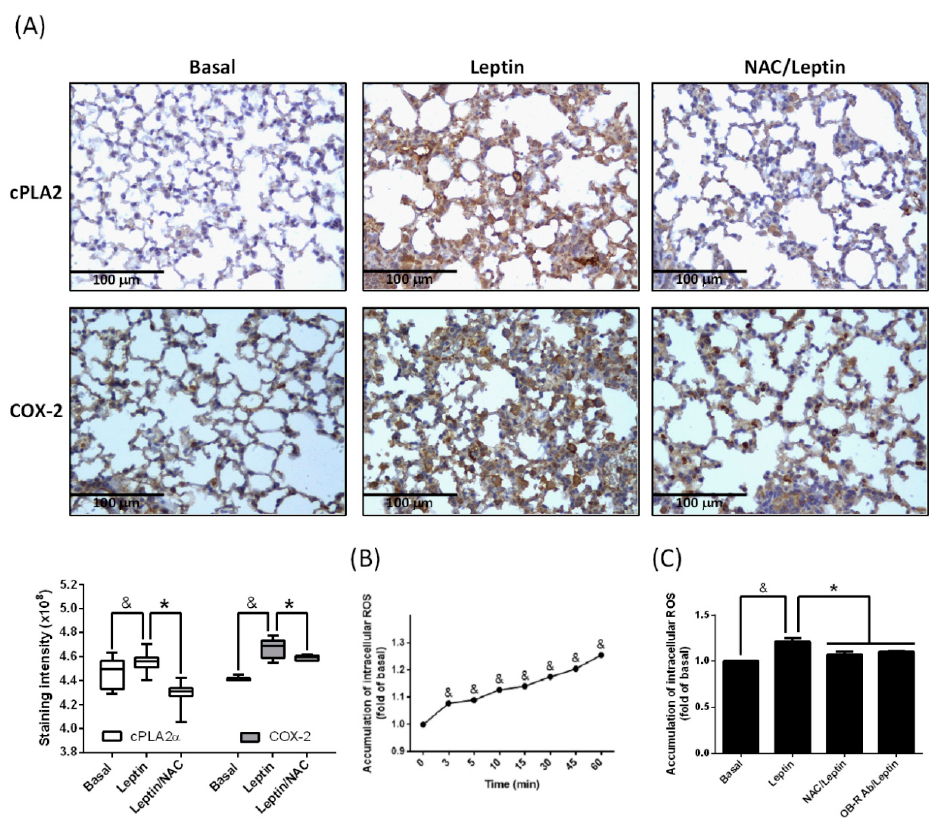
Figure 2. Participation of reactive oxygen species (ROS) in leptin-upregulated expression of cPLA2 and COX-2. ( A ) ICR mice were intraperitoneally (i.p.) injected with 2 mg/Kg of N -acetylcysteine (NAC) for 1 h then i.t. injected with 2 mg/Kg of leptin for 48 h. Expression of cPLA2 (top) and COX-2 (bottom) were shown by IHC staining. The staining intensities of cPLA2 and COX-2 are shown as box plots summarizing the median, 25th and 75th percentiles, whiskers, and outliers. ( B ) A549 cells were treated with 1 µ g/mL of leptin for the indicated time points. ( C ) A549 cells were pretreated with or without 10 µ M of NAC or 2 µ g/mL of OB-R antibody for 1 h and then stimulated with 1 µ g/mL of leptin for another 1 h. The accumulation of intracellular ROS was detected by 2 (cid:48) ,7 (cid:48) -Dichlorodihydrofluorescein diacetate (H2DCFDA) assay. Data are shown as the mean ± SEM of five independent experiments. & p < 0.05 as compared with the group of 0 min or basal group. * p < 0.05 as compared between the two indicated